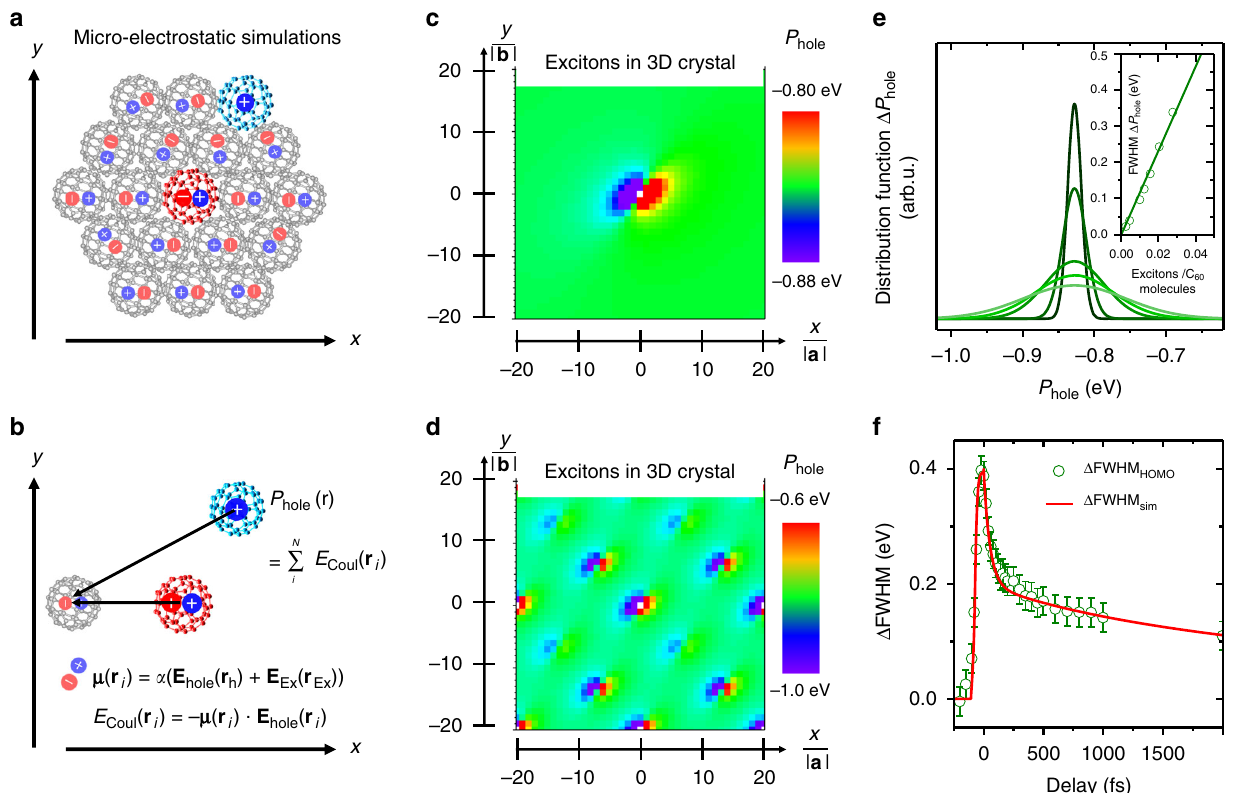
Fig. 4 Micro-electrostatic simulations of the energy renormalization of the molecular states. a Schematic overview of the micro-electrostatic simulations modeling the transient broadening of the occupied transport level in the presence of an exciton. The exciton (modeled by an electric dipole) creates an electric polarization in the fi lm by inducing dipoles at neighboring sites of highly polarizable C 60 molecules. These induced dipoles interact with the hole- like transport levels of the fi lm leading to an energy renormalization of the polarization energy P hole of the hole-like transport level depending on its relative position in the organic fi lm. Panel b illustrates the individual calculation steps of the micro-electrostatic simulations. 2D polarization energy maps P hole ( x,y ) of the surface layer of a C 60 face centered cubic (fcc) (111) crystal (slab of 6 layers) are shown for a single exciton ( c ) as well as a regular array of excitons in the fi rst three surface layers with exciton density 0.0025 excitons/C 60 ( d ). The averaged distribution functions for the polarization energies are shown in panel e together with the respective FWHM for various exciton densities as inset. f Temporal evaluation of the transient broadening of the polarization energy distribution determined by the micro-electrostatic simulations (red curve, scaled by a factor 1.5). The model considers a stepwise decay between three excited states (LUMO + 1*, LUMO*, and singlet state) of constant dipole strength ( p LUMO + 1* = 1* p 0 = e * d C60 , p LUMO* = 0.66* p 0 , and p singlet = 0.0007* p 0 ) and time-dependent population. The density of excited molecules at t 0 was 0.021 excitons/C 60, and the temporal evolution of the excited state population was described according to the time-dependent intensity of the excited states in Fig. 2d. More details on the simulations can be found in Supplementary Figure 3. For comparison, the experimentally observed transient broadening of the HOMO level and the corresponding error bars are included as green data